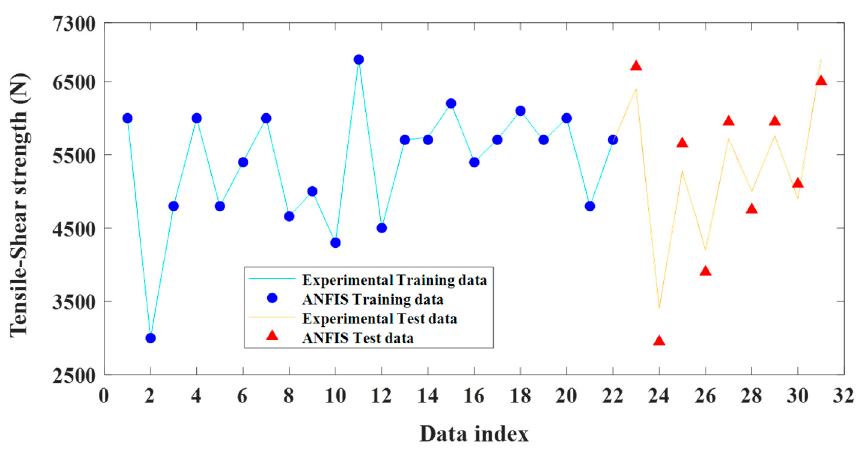
Figure 10. Difference between experimental and predicted data.